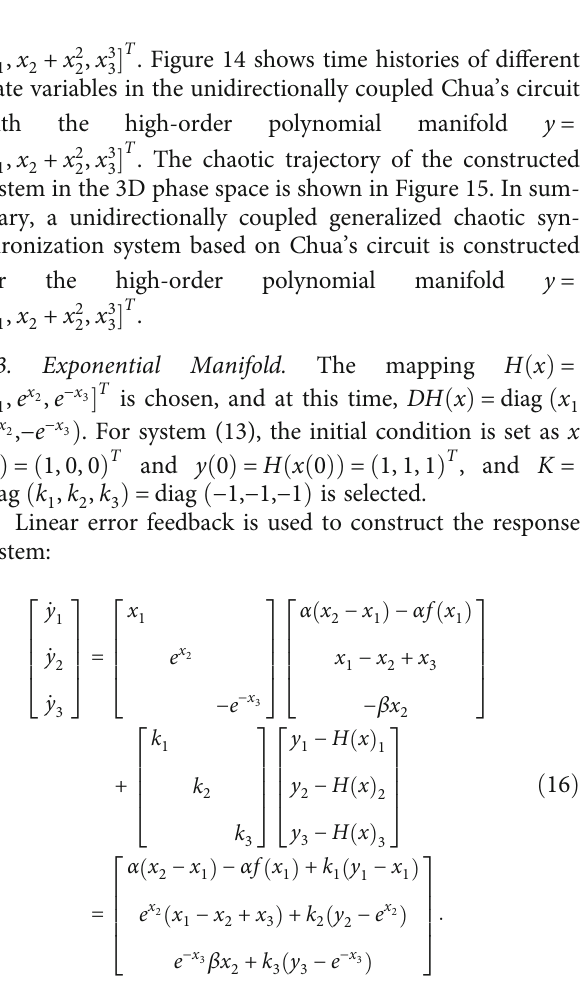
Figure 17: Time histories of di ff erent state variables in the unidirectionally coupled Chua ’ s circuit with the exponential manifold y = ½ x , e x 2 , e − x 3 (cid:2) T 1